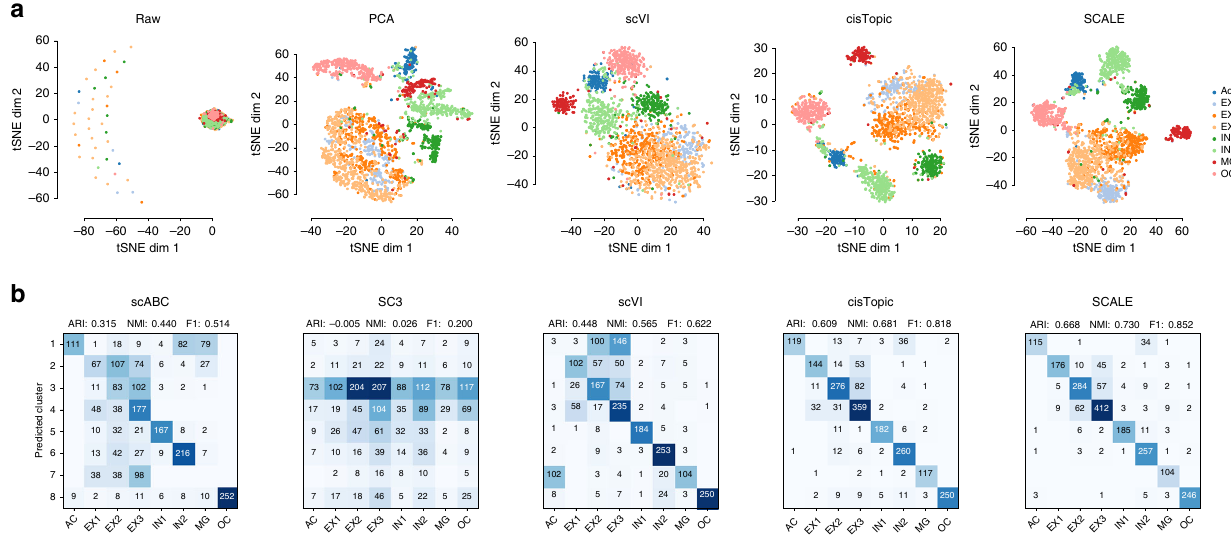
Fig. 2 Feature embedding and clustering. a t -SNE visualization of the raw data and the extracted features from PCA, scVI, cis Topic, and SCALE of the Forebrain dataset. For comparison, SCALE, PCA, and scVI all performed dimension reduction to ten dimensions before applying t -SNE while the raw data were directly visualized with t -SNE. b Clustering accuracy was evaluated by confusion matrices between cluster assignments predicted by scABC, SC3, scVI, cis Topic and SCALE, and reference cell types. For scABC and SC3, the cluster assignments were directly obtained from the output of the tools; for SCALE and scVI, we applied the K -means clustering on the extracted features to get cluster assignments. The Adjusted Rand Index (ARI), the Normalized Mutual Information (NMI), and the F1 scores are shown on the